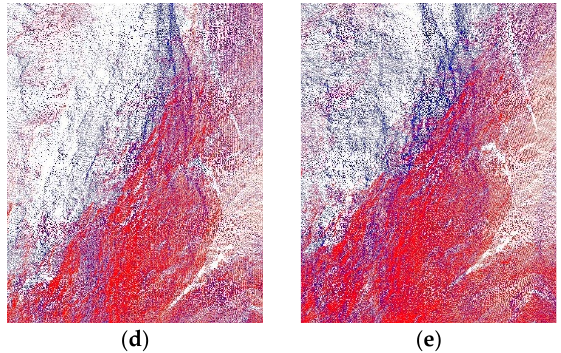
Figure 7. Local details of point cloud registration of WHU-TLS mountain dataset with different al- gorithms. ( a ) PC-MVCNN; ( b ) Improved CPD; ( c ) PointNetLK; ( d ) 3D-NDT; ( e ) SAC + ICP. Table 3. Registration results of various algorithms in WHU-TLS mountain dataset of Wuhan Uni- versity.